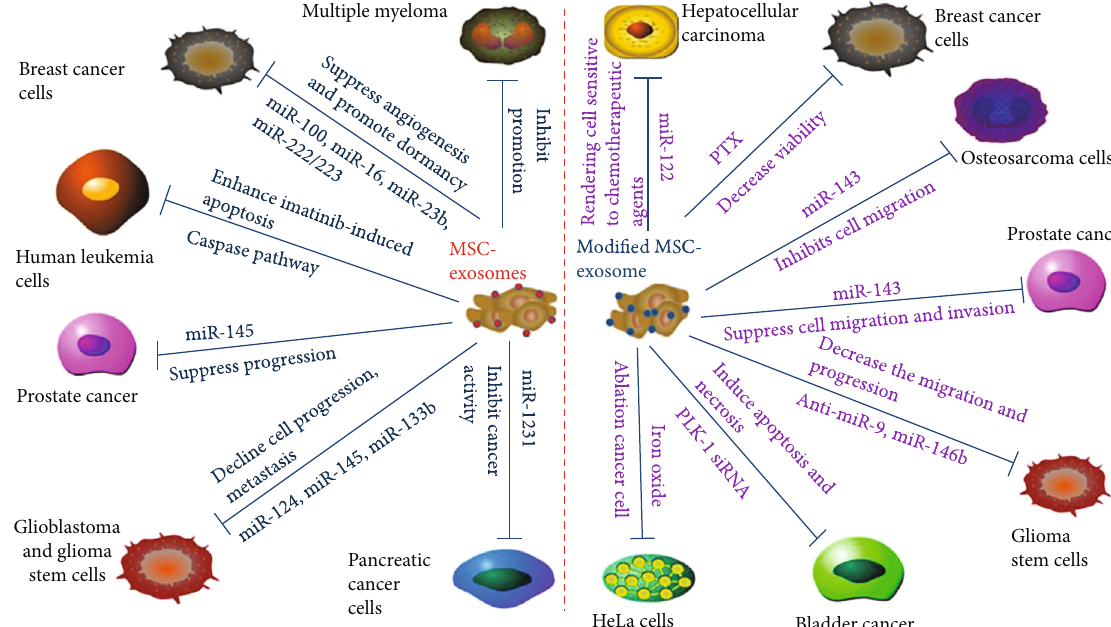
Figure 3: Inhibitory roles of MSC-derived exosomes in tumors. MSC-derived exosomes suppress angiogenesis and promote dormancy of breast cancer by shuttling miR-100, miR-16, miR-23b, and miR-222/223. MSC-derived exosomes suppress cell migration, invasion, and progression by shuttling miR-143 and miR-145. MSC-derived exosomes induce bladder cancer cell apoptosis and necrosis by transporting PLK-1 siRNA and inhibit osteosarcoma cell migration by shuttling miR-143. MSC-derived exosomes render hepatocellular carcinoma cells sensitive to chemotherapeutic agents through delivery of miR-122. MSC-derived exosomes enhance human leukemia cell imatinib- induced apoptosis through the caspase pathway. MSC-derived exosomes hinder the progression of glioblastoma and the progression and metastasis of glioma stem cells by transporting miR-124, miR-145, anti-miR-9, and miR-146b. MSC-derived exosomes inhibit pancreatic cancer activity and suppress glioma progression by shuttling miR-1231 and miR-133b. MSC-derived exosomes reduce breast cancer cell viability and the ablation of HeLa cells by transporting PTX and iron